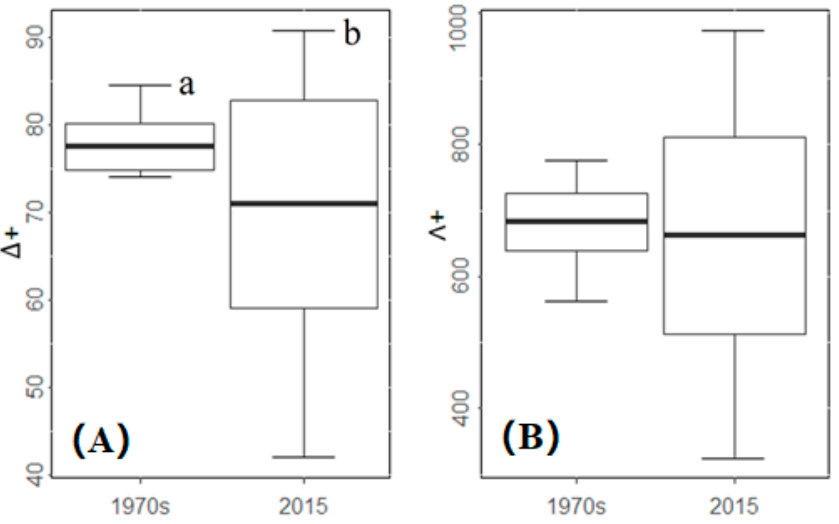
Figure 3. Values (minimum, mean ± SD, maximum) and divergence (different letters means significant differences) of the taxonomic diversity of fishes in the Min River between the 1970s and 2015. ( A ) average taxonomic distinctness ( Δ +); ( B ) the variation in taxonomic distinctness ( Λ +). Different lowercase letter means significant difference.